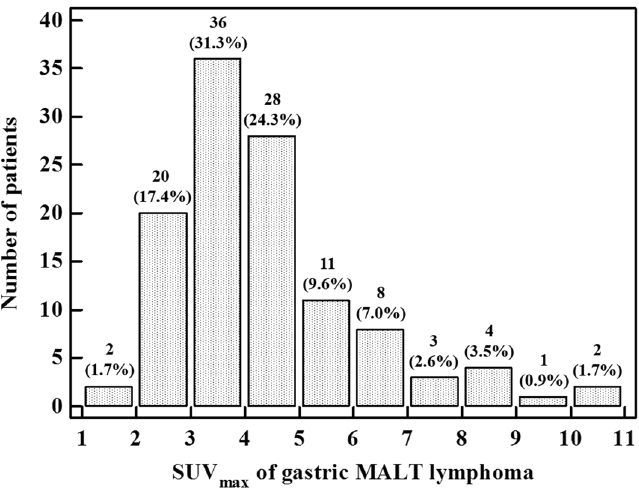
Figure 4. SUV max distribution histograms of gastric MALT lymphoma. This figure was made using MedCalc statistical software version 12.7.5.0 for Windows (Ostend, Belgium; https:// www. medca lc. org). SUV max , maximum standardized uptake value; MALT, mucosa-associated lymphoid